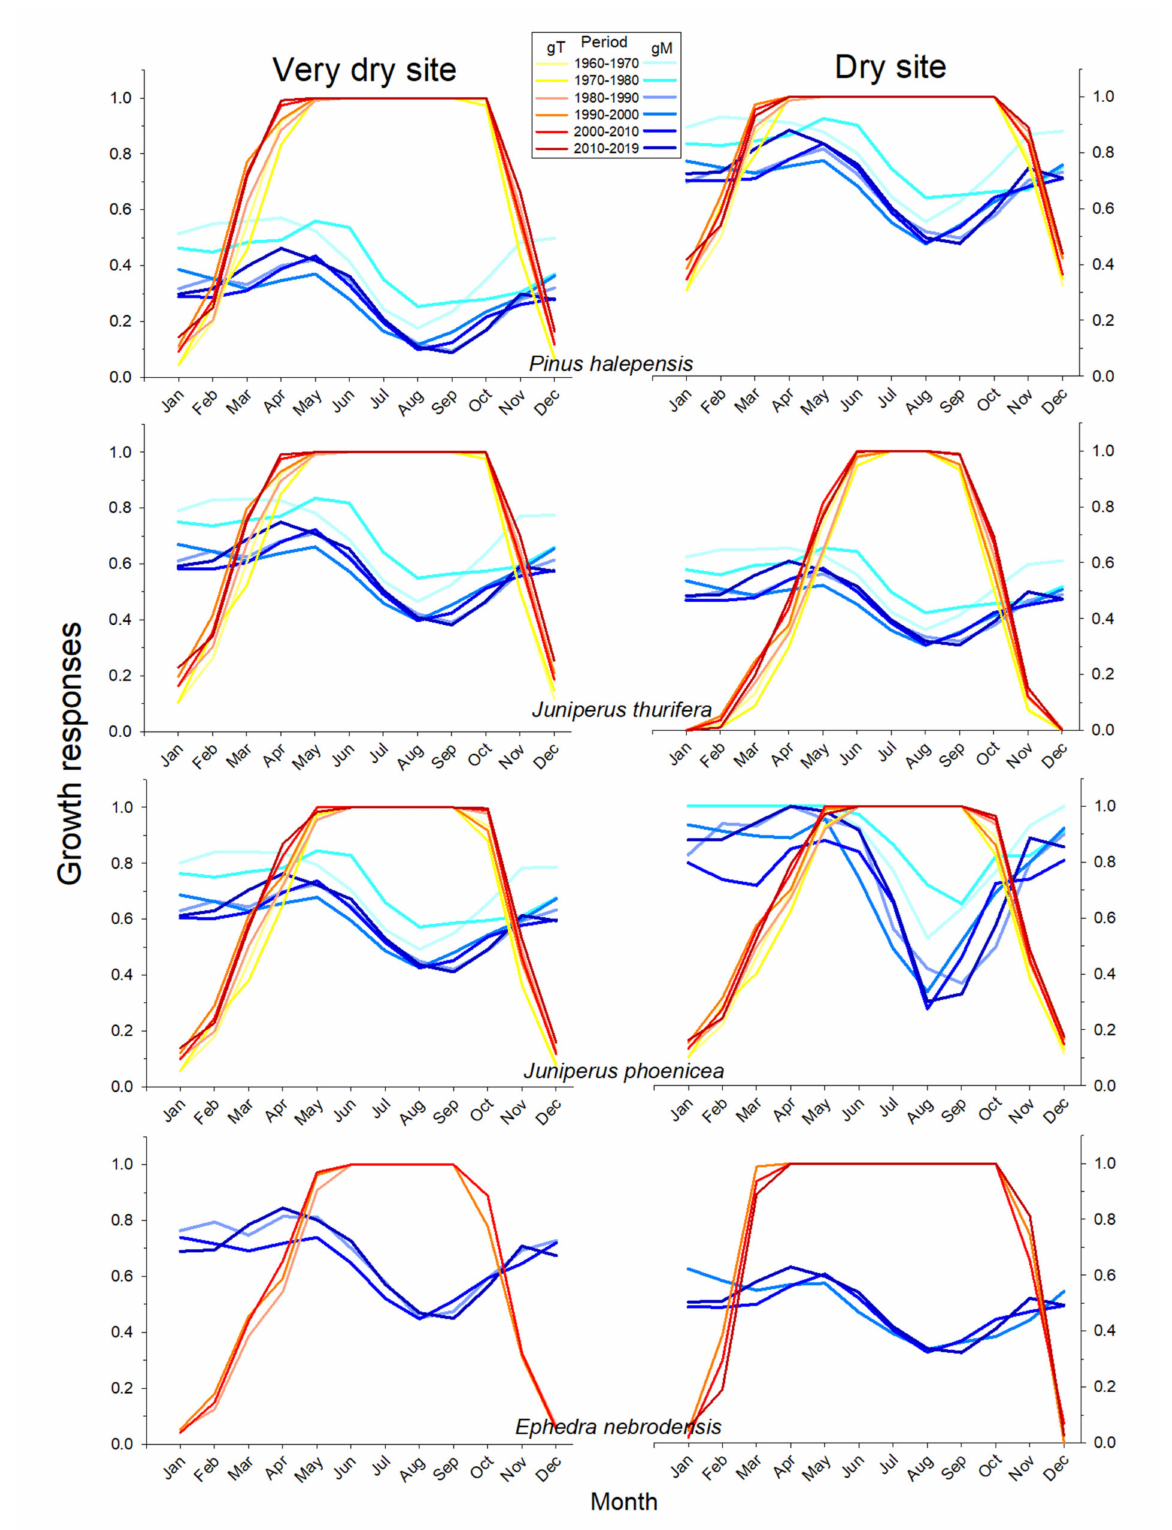
Figure 12. Temporal shifts in growth responses to temperature (gT, red to yellow-tone lines) and soil moisture (gM, blue-tone lines) averaged over decades (1960–1970, 1970–1980, 1980–1990, 1990–2000, 2000–2010, 2010–2019) for the four studied species at both sites. The increasingly hotter (higher gT) and drier (lower gM) climatic conditions during spring and autumn are becoming major growth constraints at both